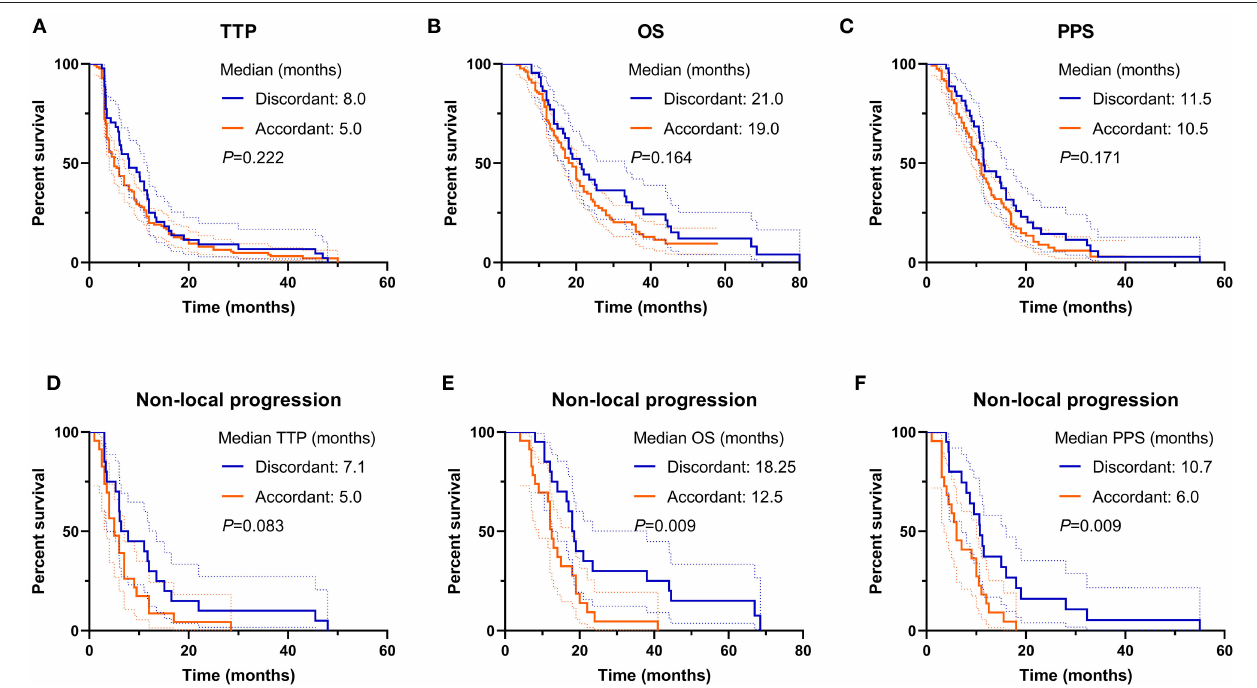
FIGURE 3 | Prognosis comparison between T2/FLAIR and T1CE discordant and accordant patients. (A–C) The TTP, OS, and PPS were not different between the two subgroups. (D–F) For non-local progression patients, the OS and PPS in discordant subgroup were favorable than accordant subgroup, but not for the TTP. TTP, time to progression; OS, overall survival; PPS, post-progression